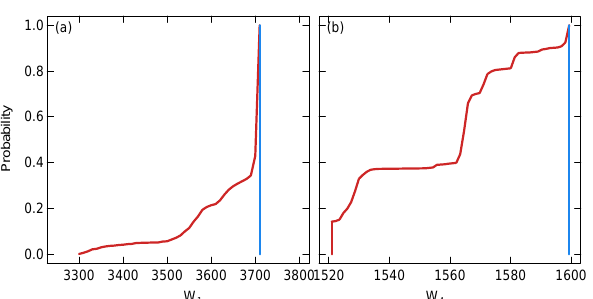
Figure 6. Empirical cumulative distribution functions representing distributions of W 1 and W 4 in PM samples ( n = 794) in red and blank samples ( n = 54) in blue.